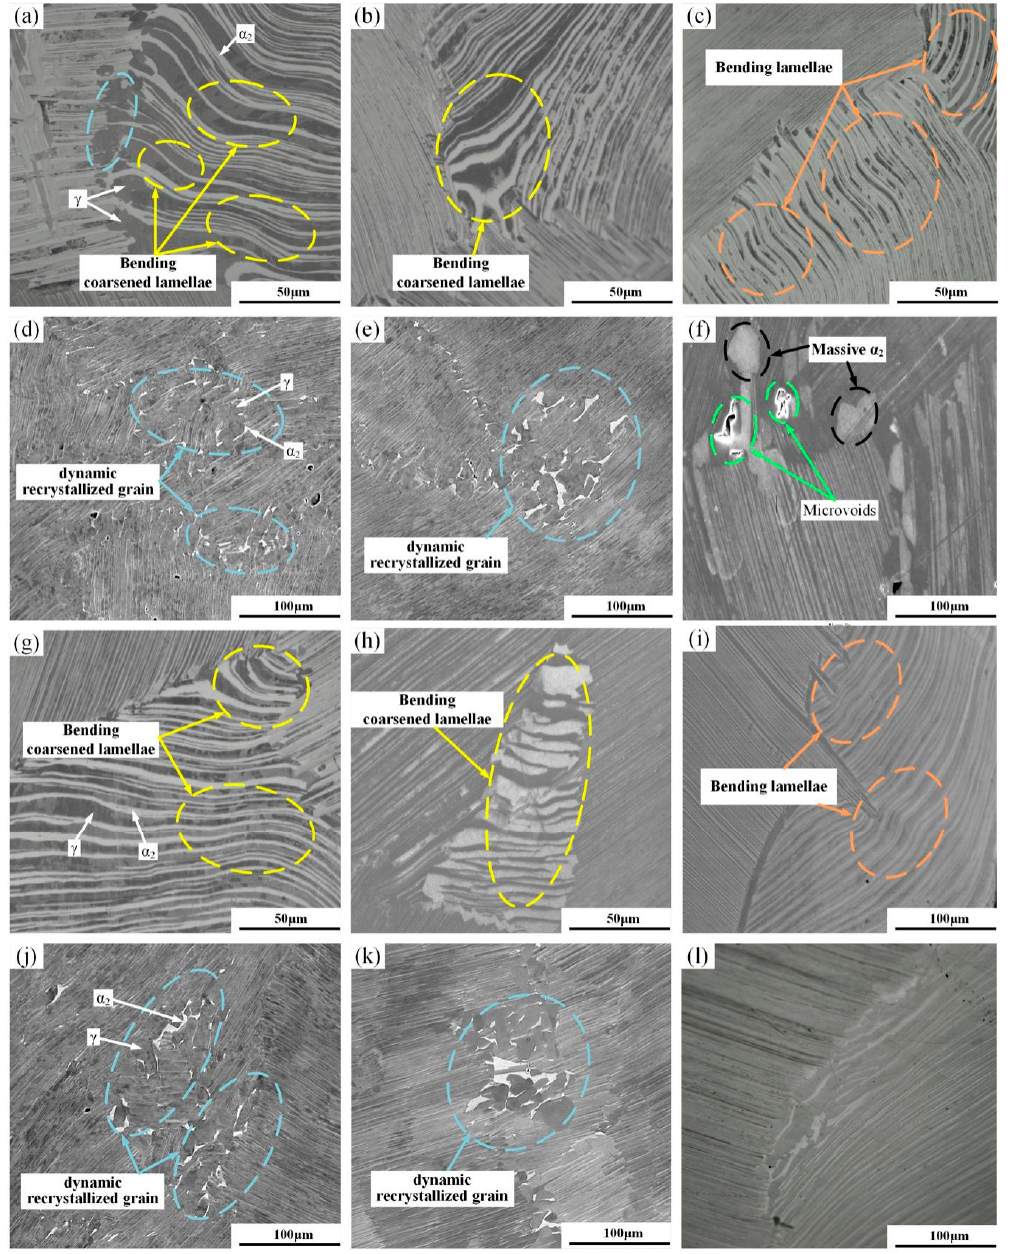
Figure 8. SEM images of the unhydrogenated ( a – f ) and hydrogenated ( g – l ) alloys deformed at ( a , d , g , j ) 1150 °C/0.0004 s − 1 , ( b , e , h , k ) 1150 °C/0.001 s − 1 , and ( c , f , i , l ) 1150 °C/0.0025 s − 1 . Through a comparison with previous work, it was found that the influence of hydrogen on the